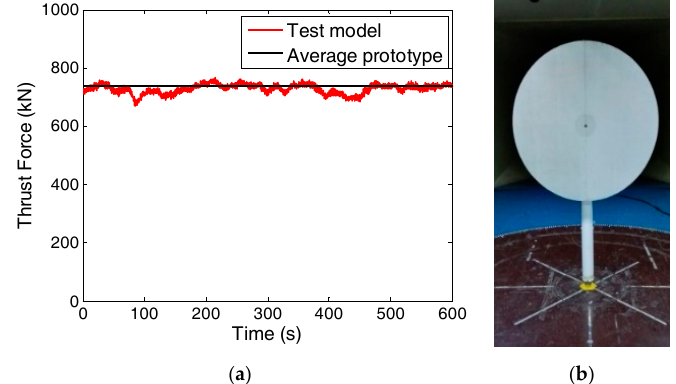
Figure 3. Wind turbine calibration test: ( a ) Thrust force comparison between the model and the prototype; ( b ) Simplified wind turbine model for rated operational